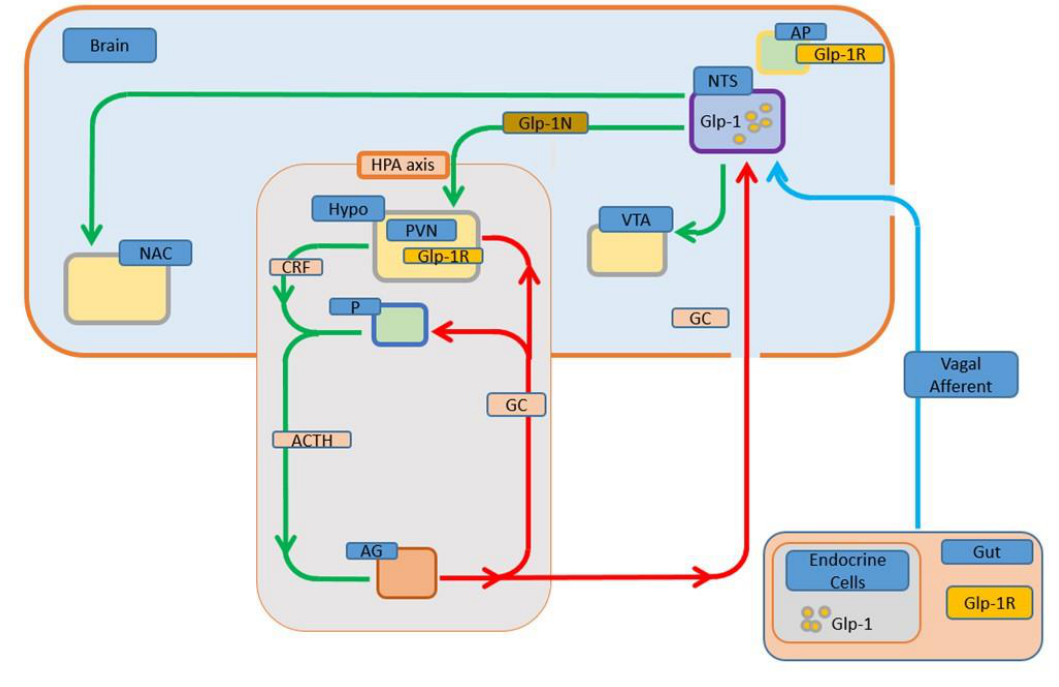
Figure 1. Representative scheme of the interactions and effects of GLP-1 at the central